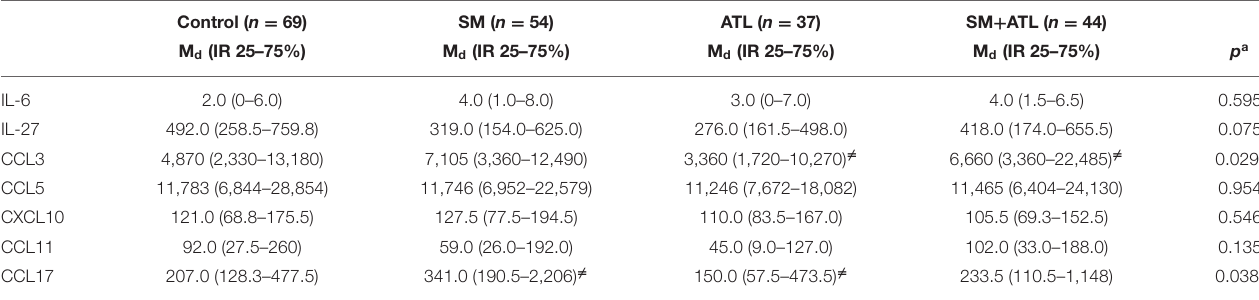
TABLE 4 | Serum levels of IL-6, IL-27, CCL3, CCL5, CXCL10, CCL11, and CCL17 in patients with different parasitic infection profiles living in the rural community of Brejo do Amparo, Januária, Minas Gerais, Brazil. Control ( n =